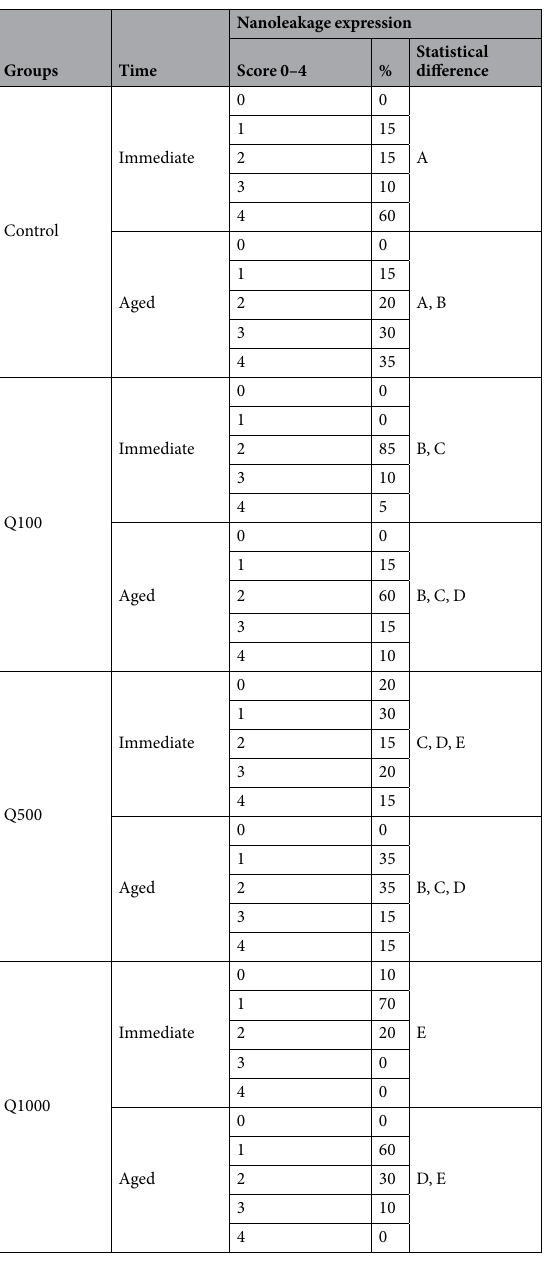
Table 2. Percentage distribution of nanoleakage scores from each group. Kruskal–Wallis test with Dunnett’s post-hoc test. Groups with the same letters are not statistically different ( P > 0.05), n =